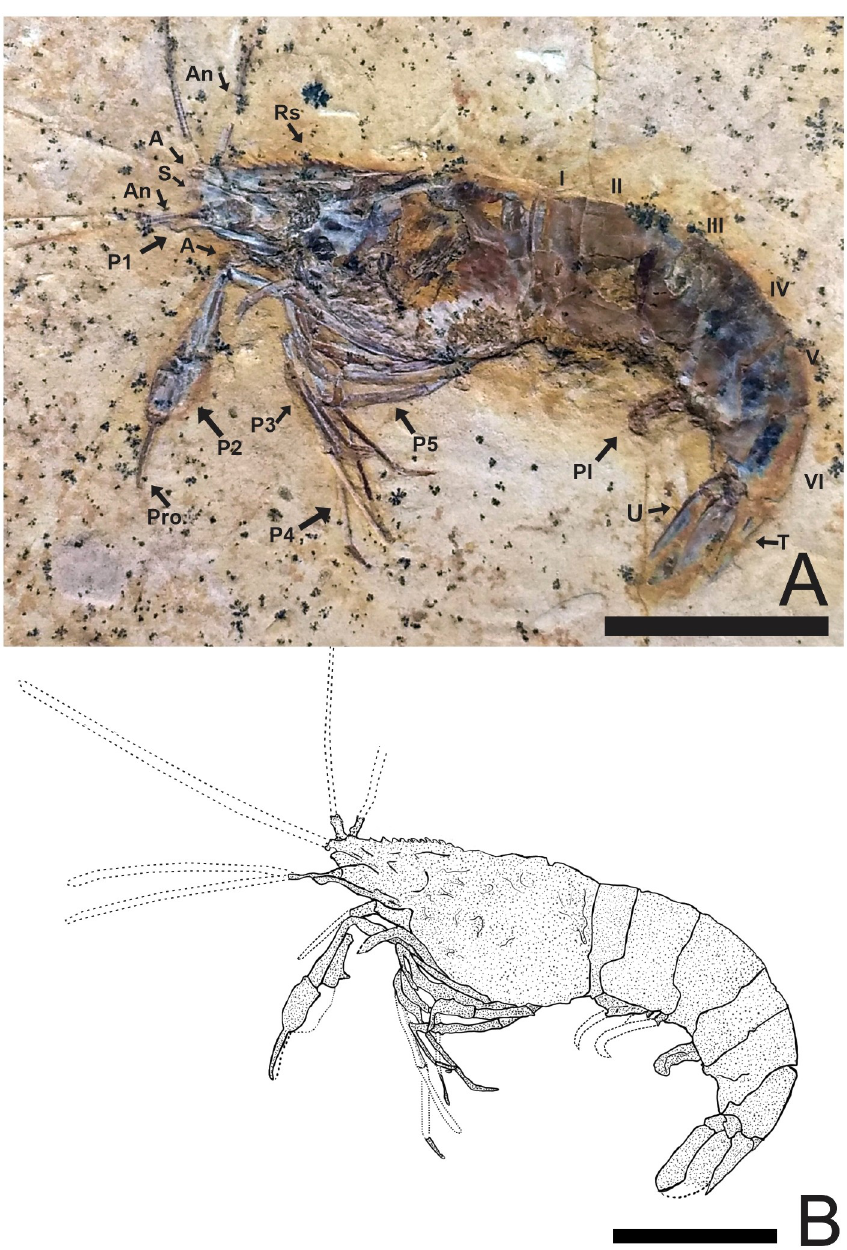
Scaphocerite; I-VI: Pleon; P1-P5: Pereiopods; Pro: Propodus; Pl: Pleopods; T: Telson; U: Uropods. Scale bars: 5 mm. Photo and drawing by Olga A. Barros.